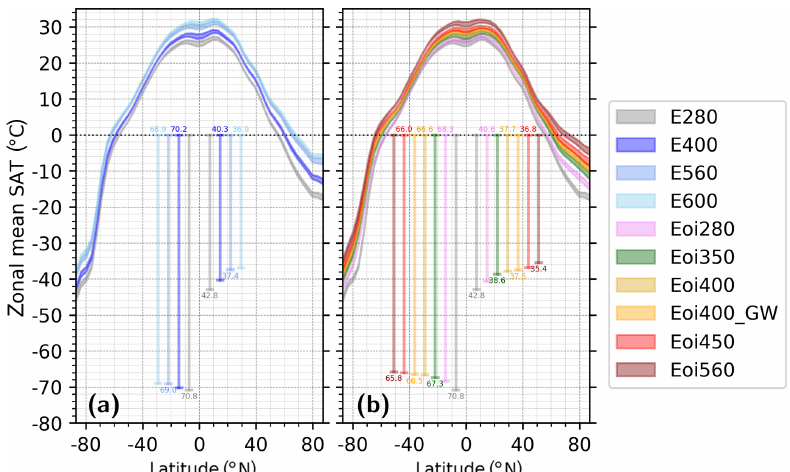
Figure 8. Meridional range of zonal mean surface air temperature (SAT), averaged over both ocean and land, for various levels of atmospheric carbon dioxide. Shading illustrates time variability over the analysis period. Shown are simulations for (a) modern geography and (b) mid- Pliocene geography. Vertical bars provide a visualisation of the meridional gradient of SAT for both the Southern Hemisphere (left of 0 ◦ N) and Northern Hemisphere (right of 0 ◦ N). The computation is based on the lowest and highest latitude of each hemisphere, which does not necessarily provide the largest temperature range available within a hemisphere. We define SAT as the temperature at a height of 2m above the surface.